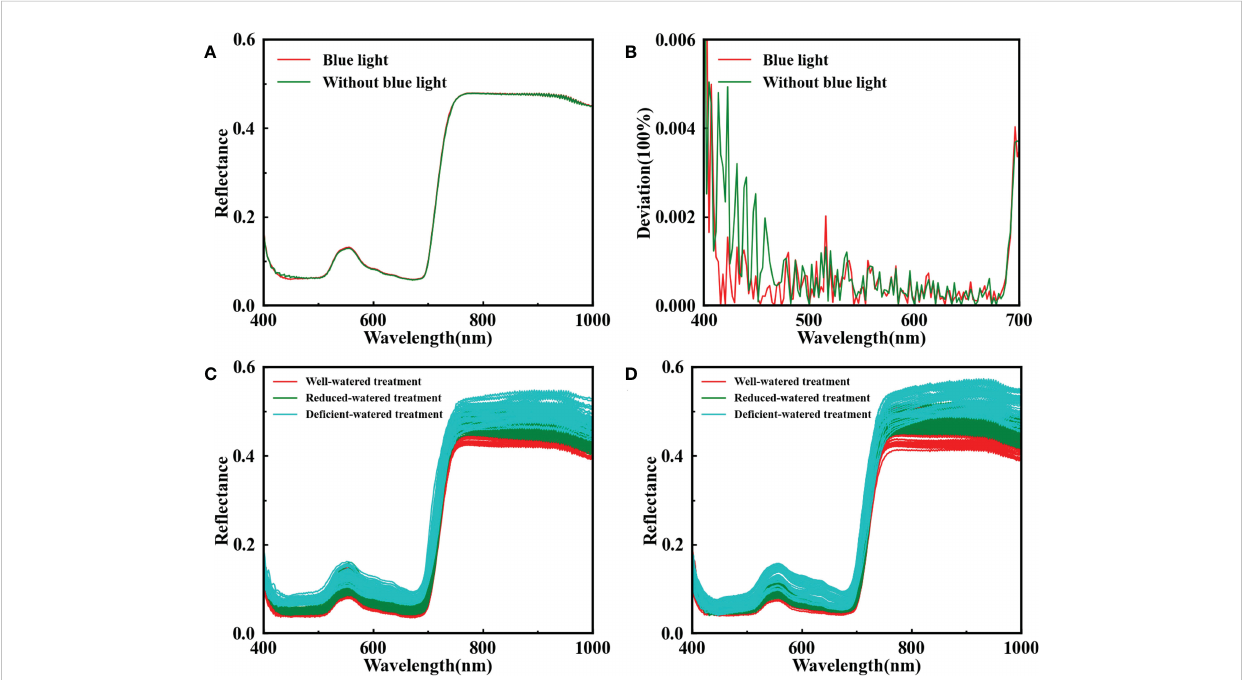
FIGURE 4 Re fl ectance spectra of the leaf with blue lights (red line) and without blue lights (green line) in the range of 400 – 1000 nm (A) ; the deviation calculated by subtracting between the raw spectrum and the spectrum smoothed with Savitzky-Golay at 400 – 700 nm (B) ; re fl ectance spectra for all available young leaves (C) and mature leaves (D) under different water